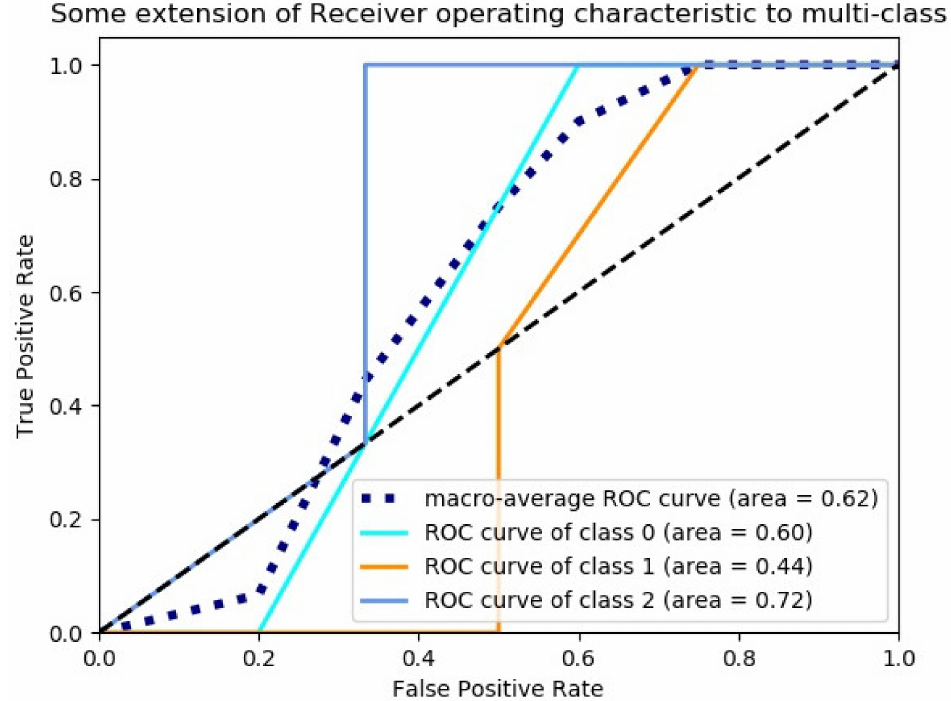
Figure 10. KNN classification model ROC curve and area under the ROC